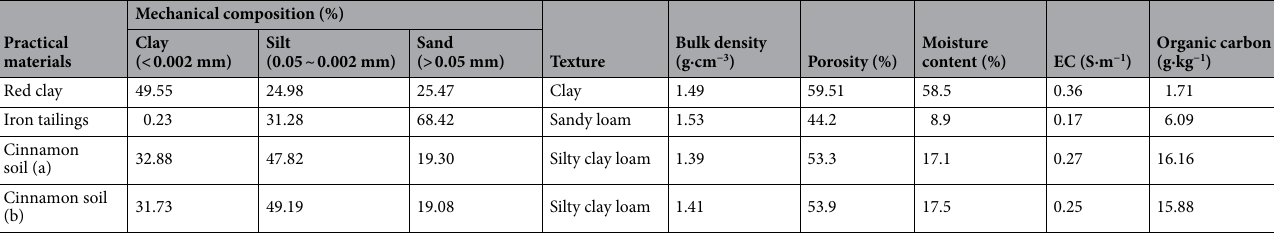
Table 1. Essential characteristics of the practical